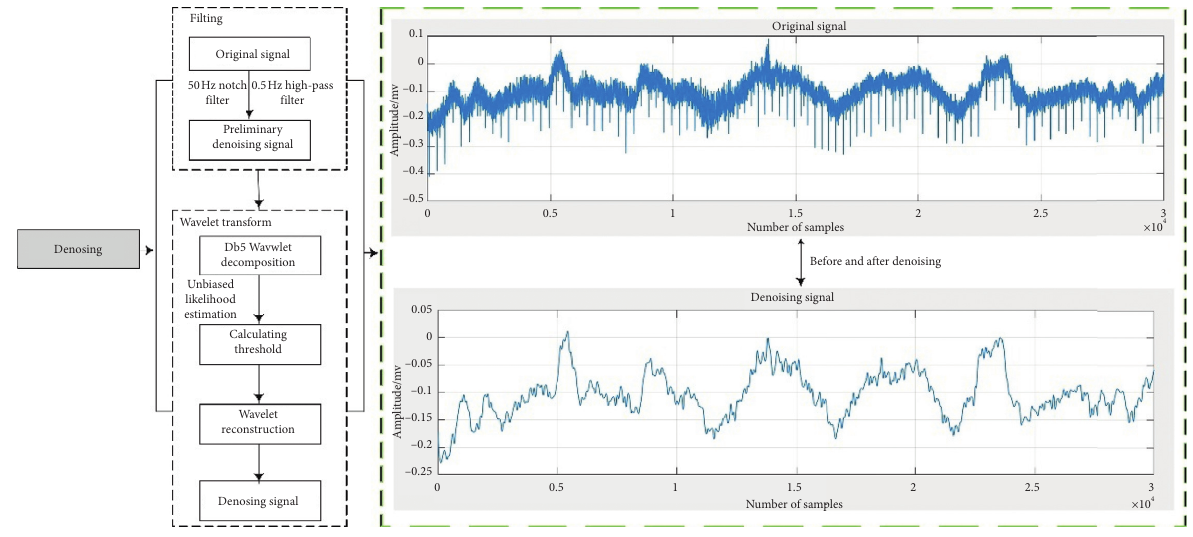
Figure 12: ECG signal Table 2: HRV time-domain indicators.